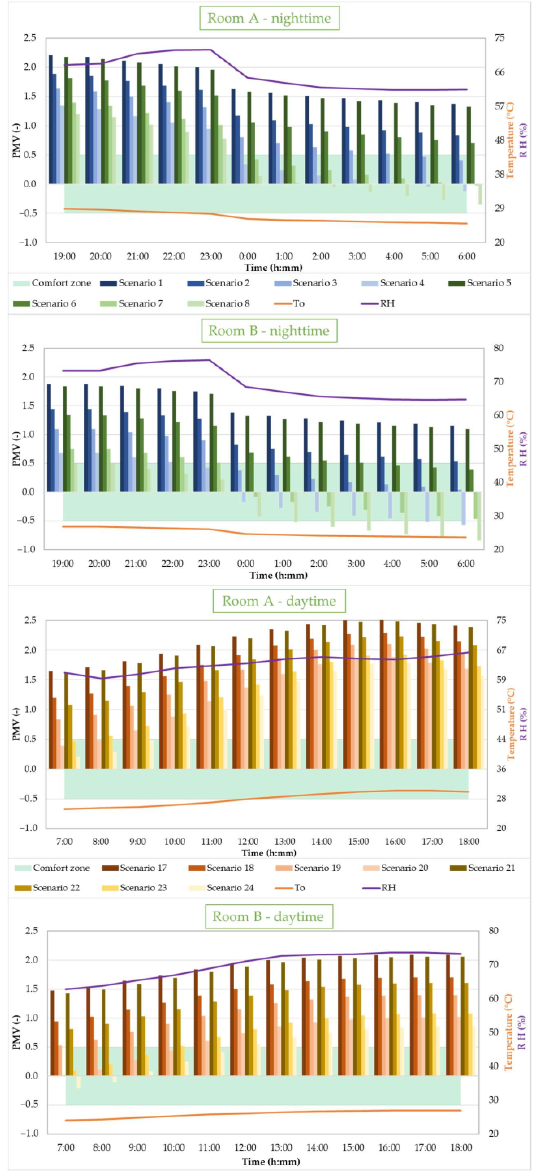
Figure 15. Hourly operative temperature, relative humidity, and PMV in rooms A and B with a bedridden patient: different scenarios in the autumn